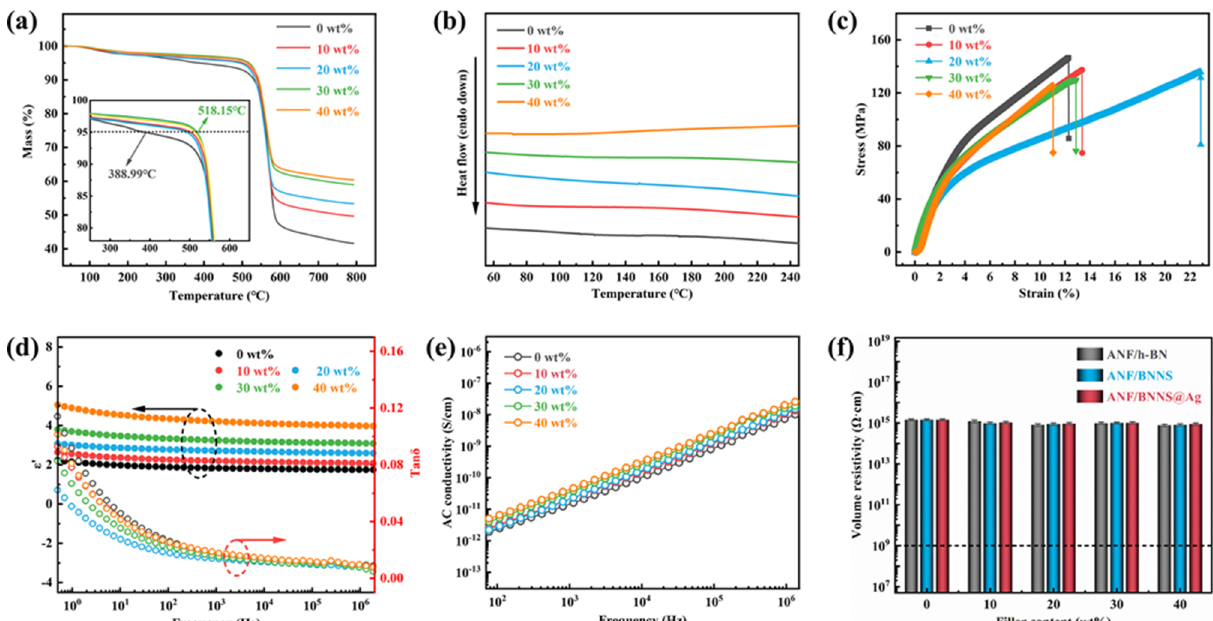
Figure 5. ( a ) TGA curves, ( b ) DSC curves, ( c ) stress-strain curves, ( d ) frequency dependence curves of dielectric constant and dielectric loss tangent, and ( e ) AC conductivity curves of pure ANF and ANF/BNNS@Ag films with various contents. ( f ) Volume resistivity of the different composite films with various filler contents.